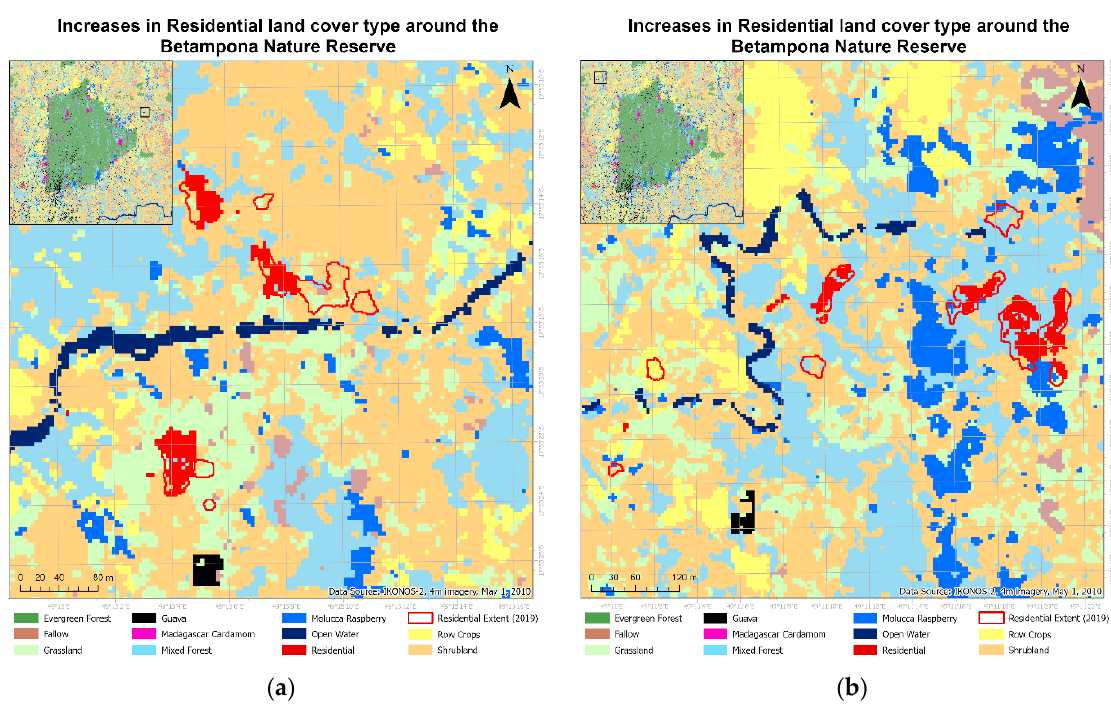
Figure 10. Residential areas in 2019 (red boundary polygon) in the study area (extent shown in inset map) overlain over the 2010 classification map showing the increase in residential area extent and the emergence of new hamlets in 2019 for ( a ) a location east of the BNR and ( b ) northwest of the